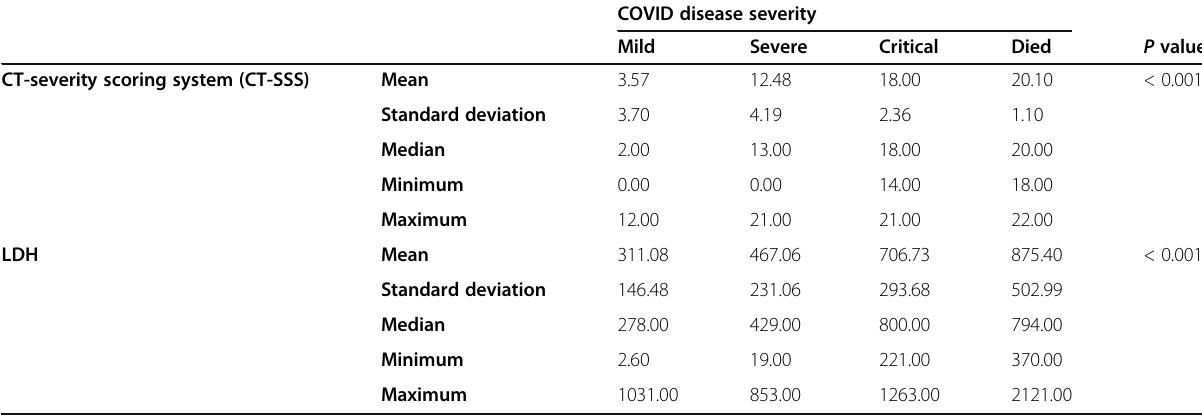
Table 2 Correlation between CT-SSS, LDH, and disease severity